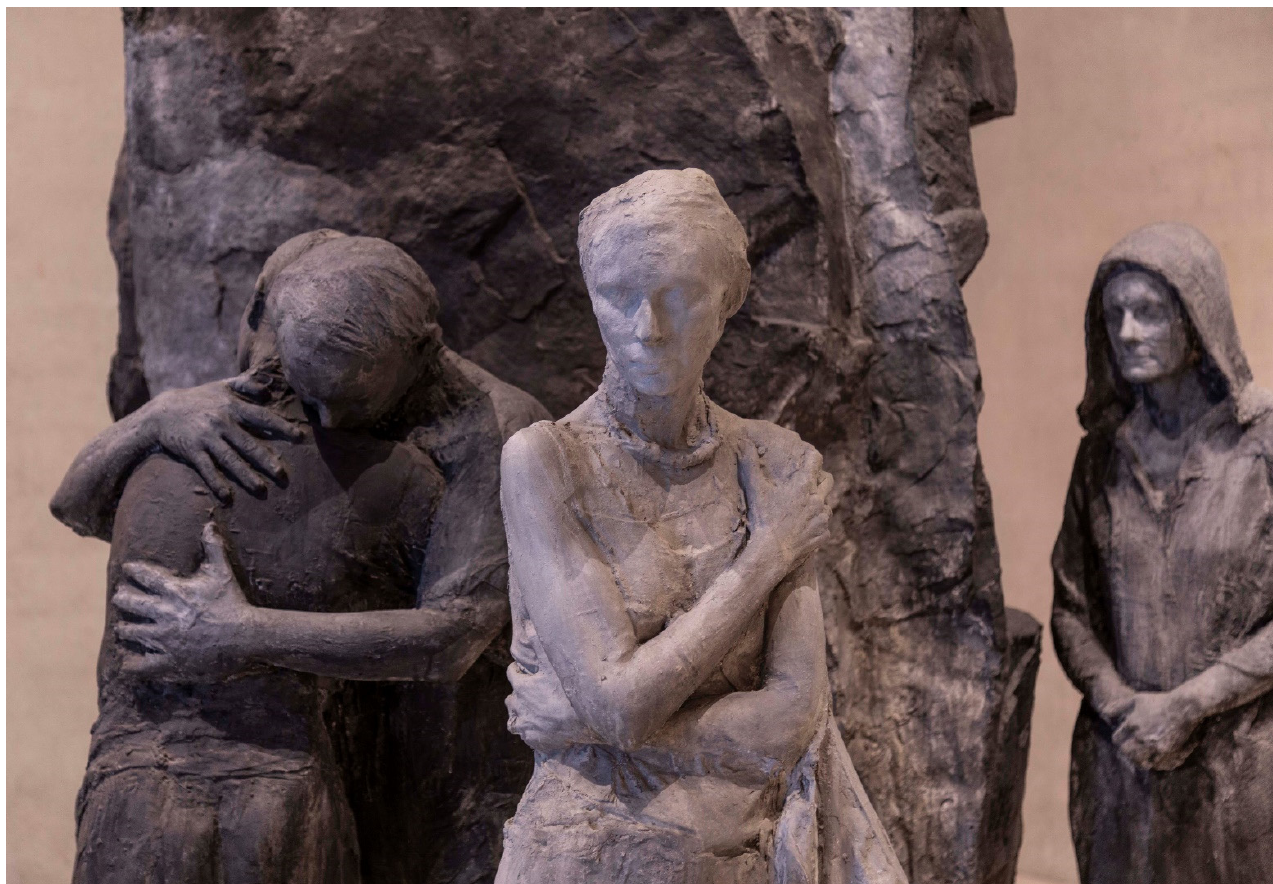
Figure 19. George Segal, Abraham’s Farewell to Ishmael , 1987. Pérez Art Museum Miami.